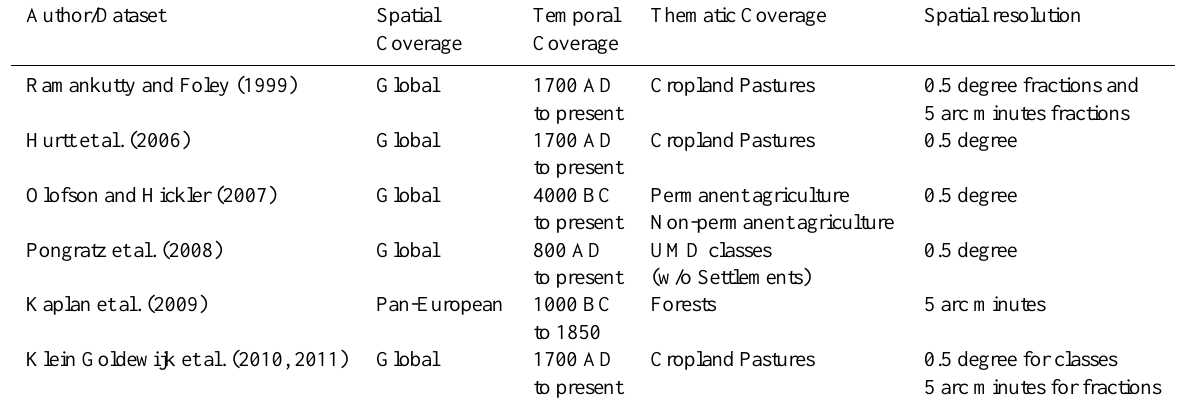
Table 1. Examples of geographically explicit studies of historical land cover/use, suitable for a Europe-wide